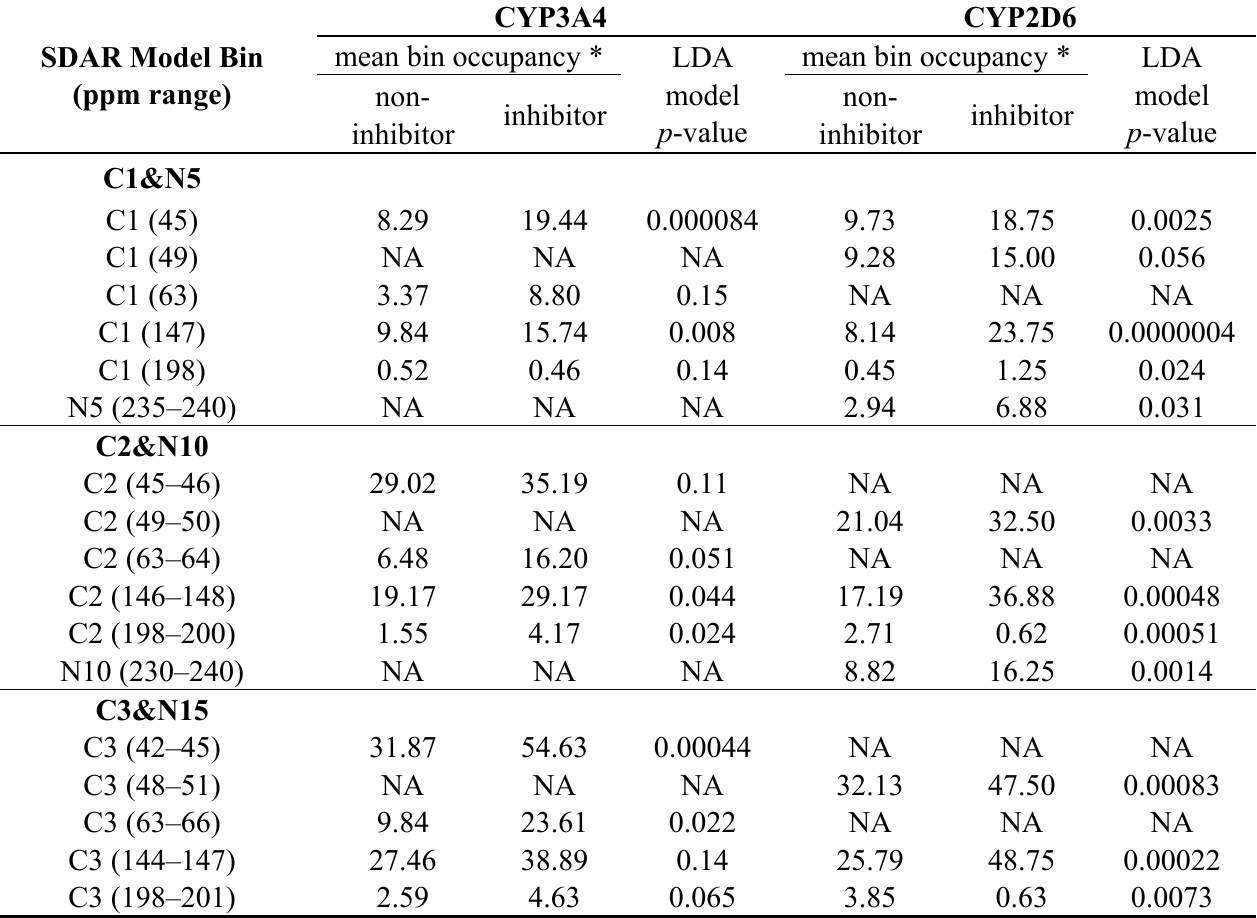
Table 7. Mean values and p -values of selected bins used in C1&N5, C2&N10, and C3&N15 SDAR LDA models with F >